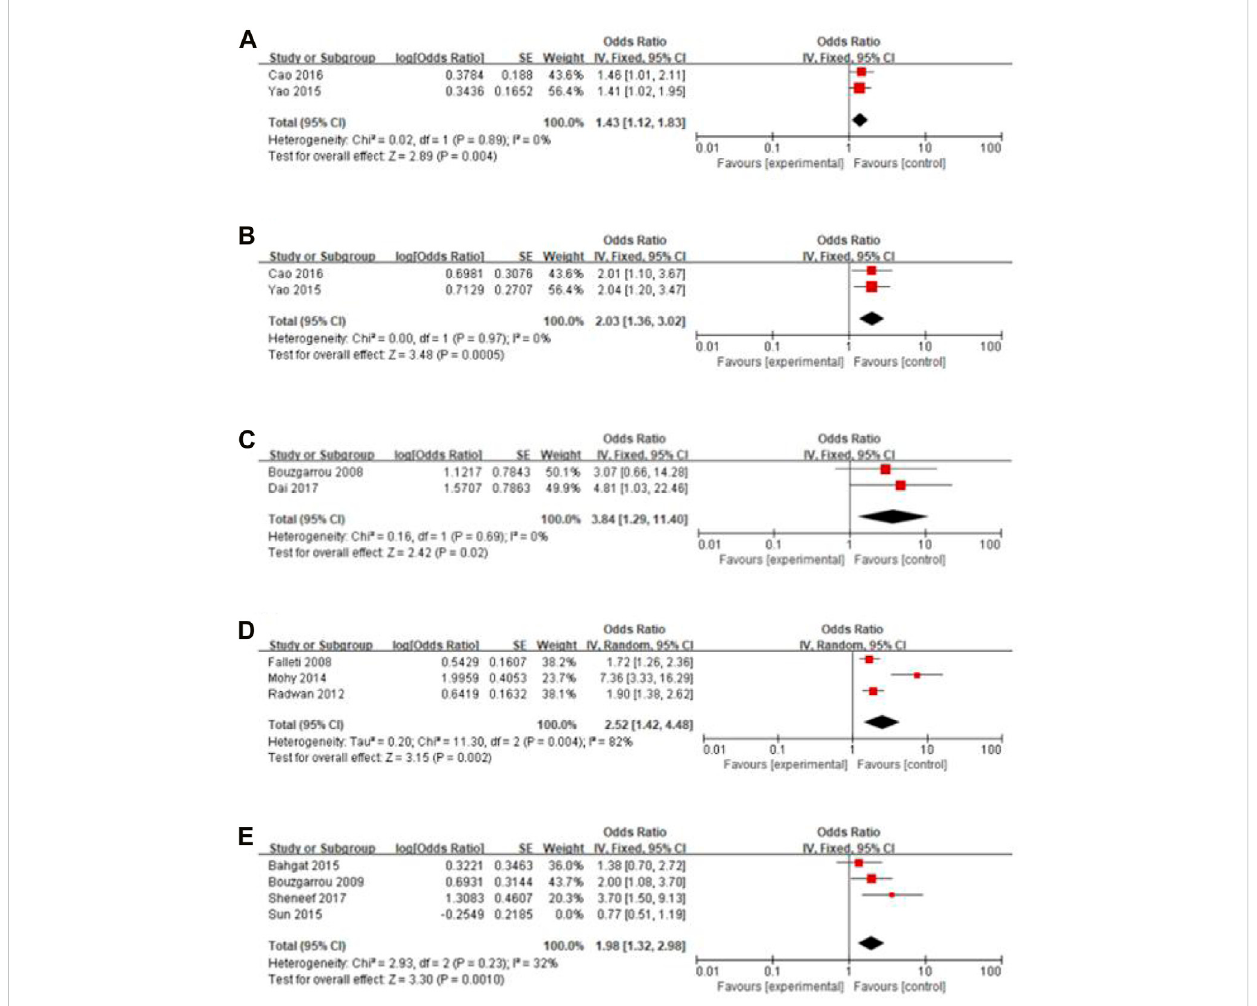
FIGURE 2 Forestplotofthesigni fi cantresults. (A) IL-10 – 1082 GA+AAvs.GG; (B) IL-10 – 1082AAvs.GG; (C) IL-18-137 GGvs.CC; (D) TGF- β 1-509 Tvs.C; (E) IFN- γ +874 T vs.